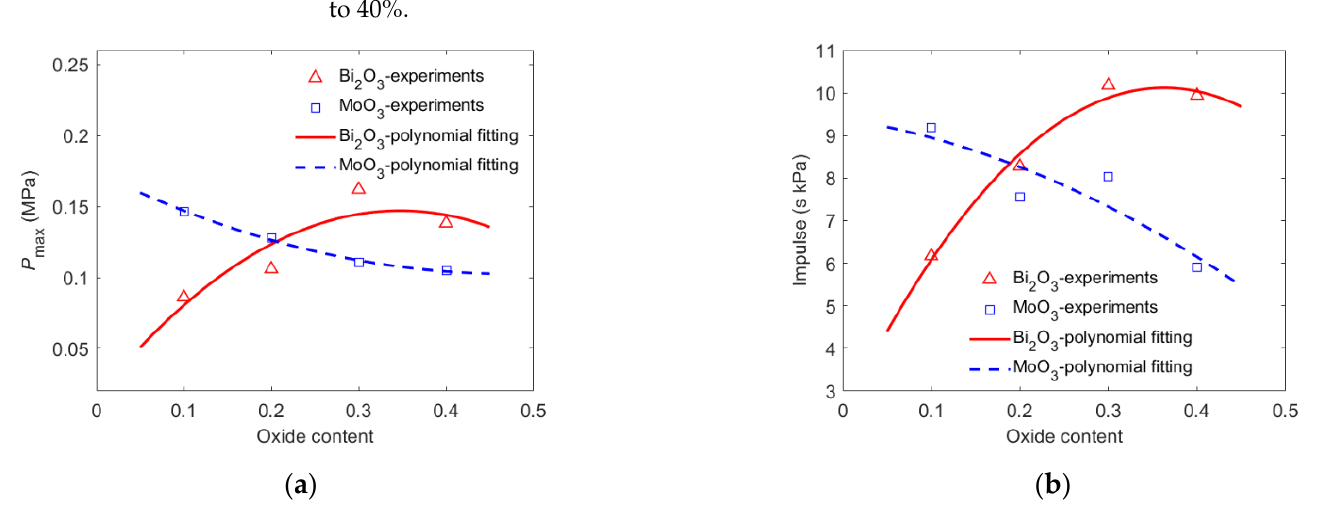
Figure 5. Pressure characteristics vary with content: ( a ) pressure peak varying with oxide content; ( b ) impulse varying with oxide content.